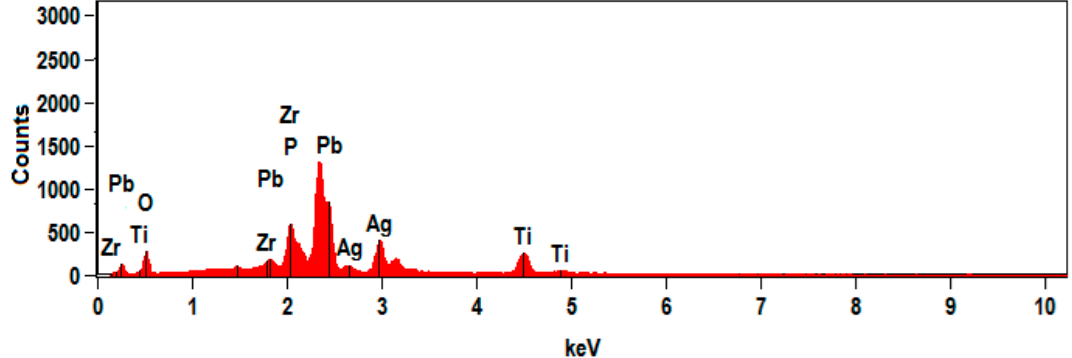
Figure 1. Energy-dispersive spectroscopy (EDS) spectrum of the lead zirconate titanate (PZT) piezoelectric wafer active sensors (PWAS).